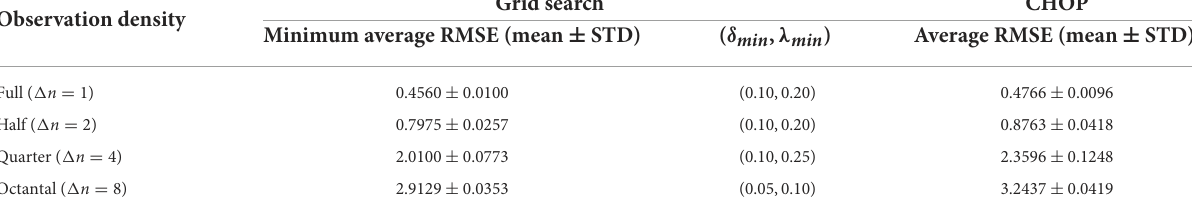
TABLE 2 As in Table 1, but for performance comparison between the grid search method and the CHOP workflow with full, half, quarter, and octantal observations, respectively, whereas the ensemble size and the observation frequency are set to 30 and 4, respectively, in all experiments. Grid search Observation density